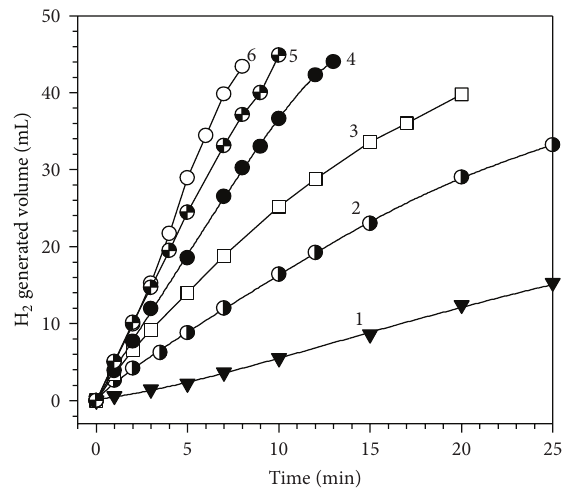
Figure 4: Volume of hydrogen generated from 5mL of 0.1 NaBH 4 + 0.33 mol/L NaOH solution at 30 ∘ C as a function of processing time for synthesized Co (1) , Ru (6) , and Co-Ru alloy catalysts containing 2.6 (2) , 3.8 (3) , 5.7 (4) , 7.1 (5) , and 11.1 (6) at% Ru each in 5mg.